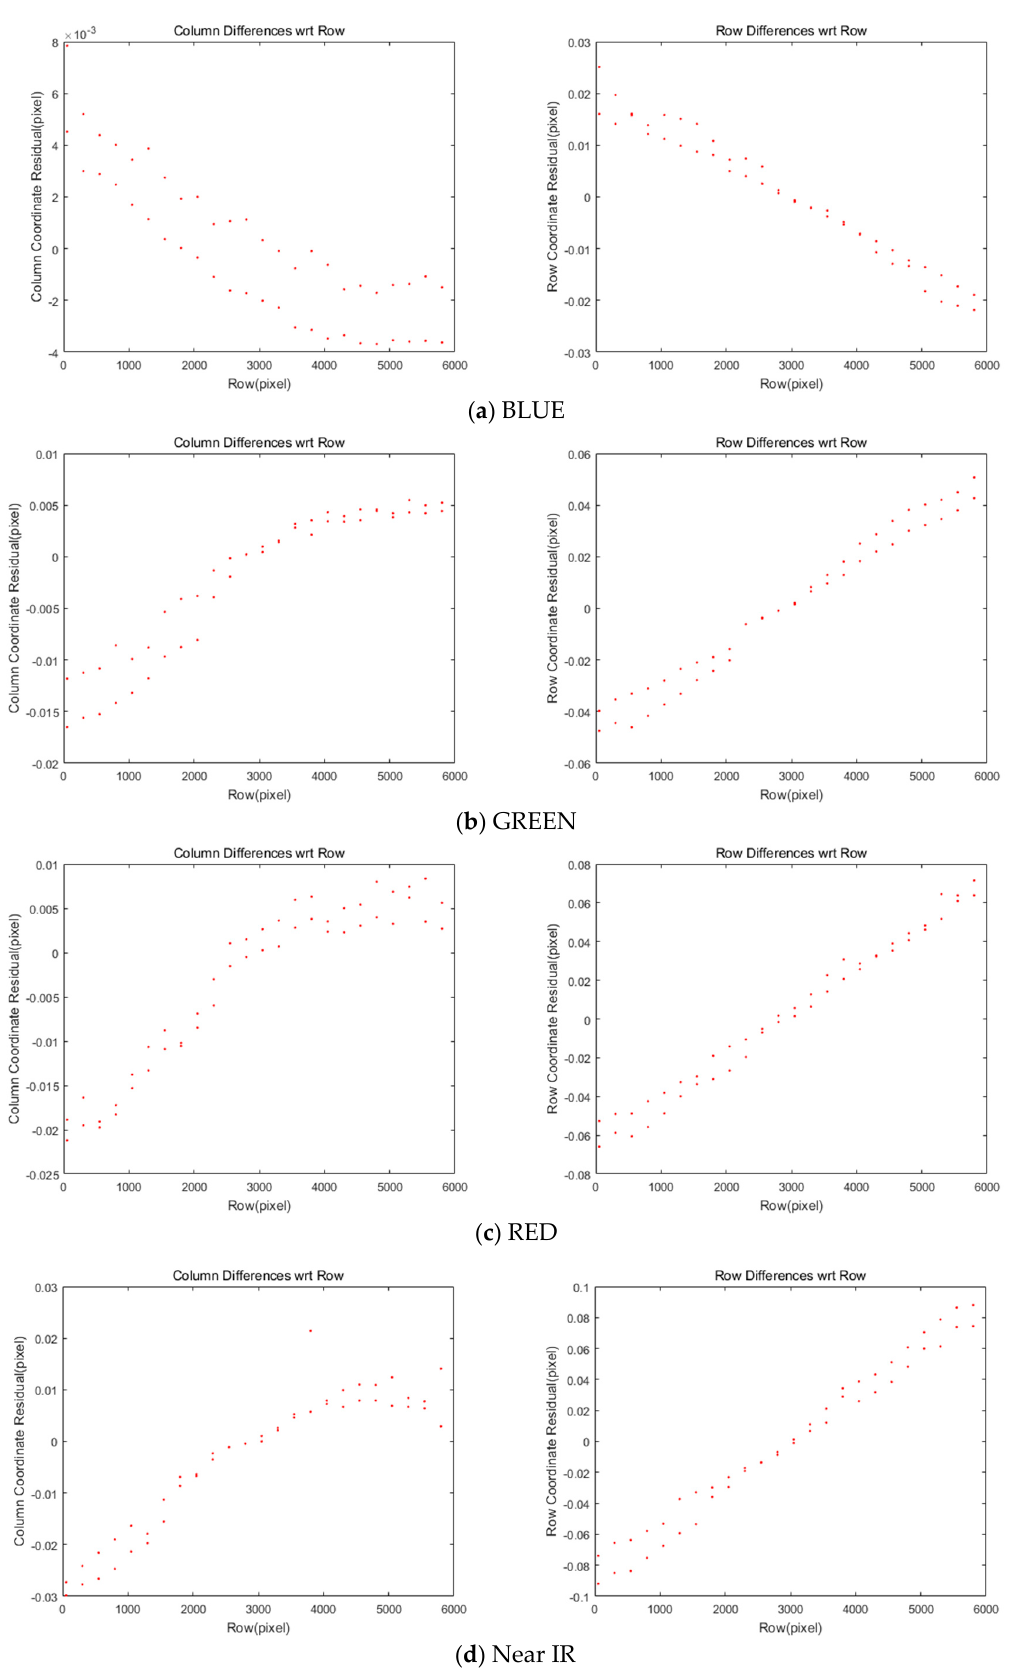
Figure 9. Differences in rows and columns in coordinates between MS and PAN images after attitude change compensation. Table 8. Differences in rows and columns in coordinates between MS and PAN images after attitude change compensation.